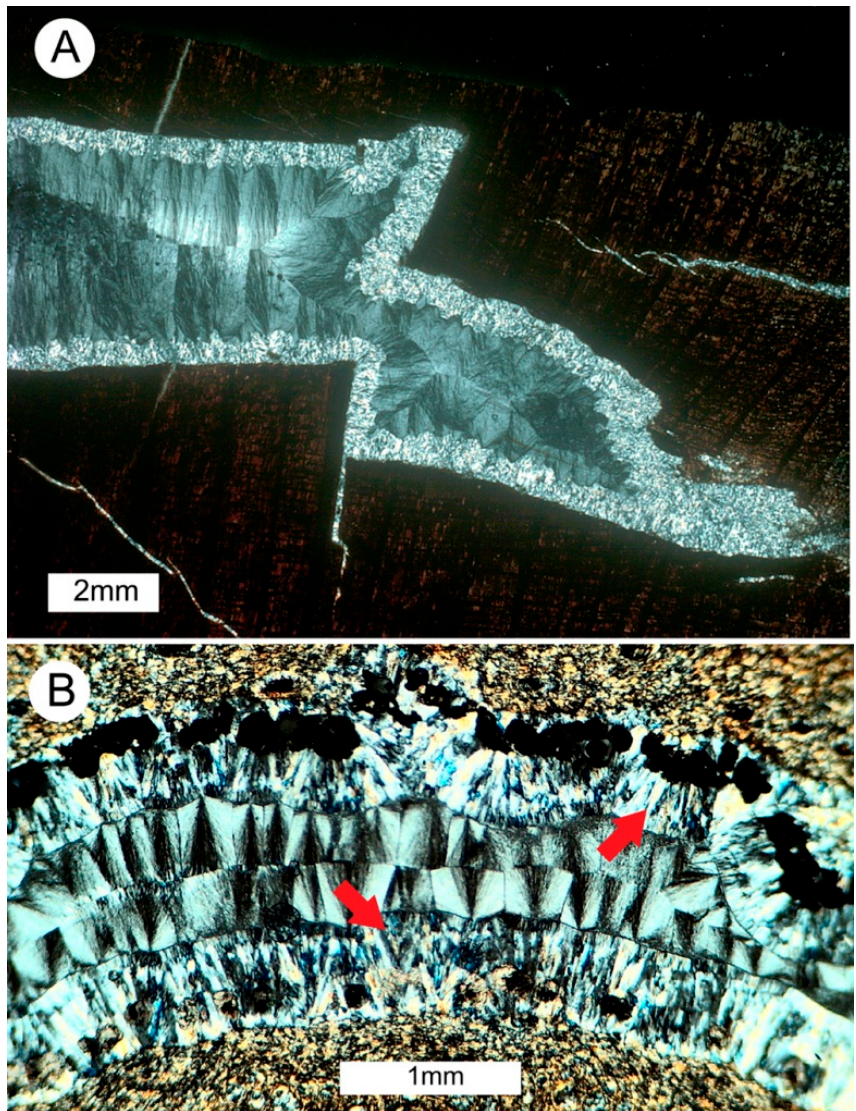
Figure 18. Polarized light optical photomicrographs of chalcedony in fractures. ( A ) Two layers of chalcedony fill an angular fracture. ( B ) In this shrinkage zone, the outer chalcedony layer shows a botryoidal form (arrows), the inner zone consist of polygonal sectors with a radiating fibrous